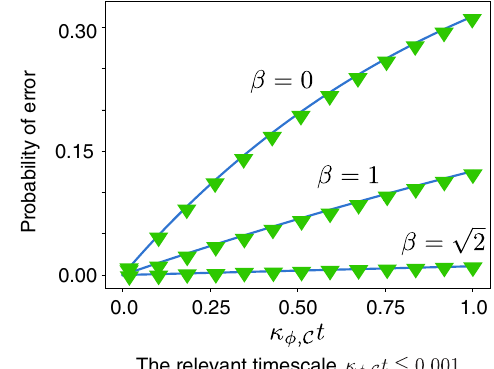
FIG. 12. Comparison of dephasing predicted by (i) the effective two-level master equation in Eq. (D1) (solid line) and (ii) the master equation of a PCO coupled with a finite-linewidth 1 (triangles). In all the oscillator given by Eq. (D2) with n th ¼ cases, K is fixed while P is varied so that β changes from 0 to 1 ffiffiffi p 2 1 , and and . The parameters are chosen as g ¼ 0 . 0025 K , n th ¼ κ 0 . 05 K so that κ 0 κ 0 . 0005 K . The probability of a ϕ ; C ¼ ϕ ; C ¼ bc ¼ phase-flip error is estimated by initializing the PCO to the state jþi and estimating h − j ˆ ρ PCO j − i . For example, the probability of ffiffiffi p 2 is 0.0125. In practice, phase-flip errors for β ¼ at t ¼ 1 = κ ϕ ; C the stabilizer measurements typically take time T ¼ 1 =K – 10 =K , T ¼ 0 . 0005 – 0 . 005 ≪ 1 . and so the relevant timescales are κ ϕ ; C